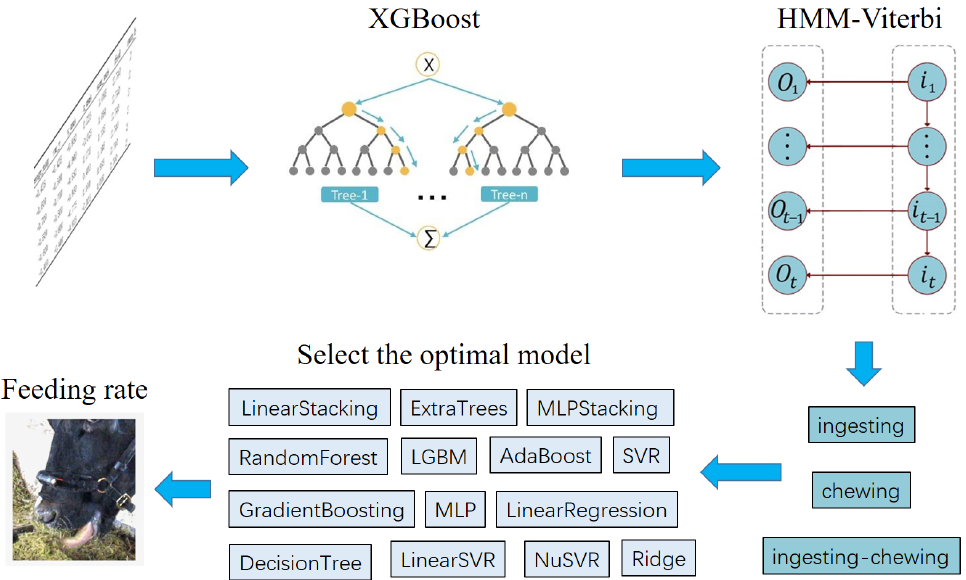
Figure 3. Flow chart of predicting feed intake rate after identification of jaw movement activities.